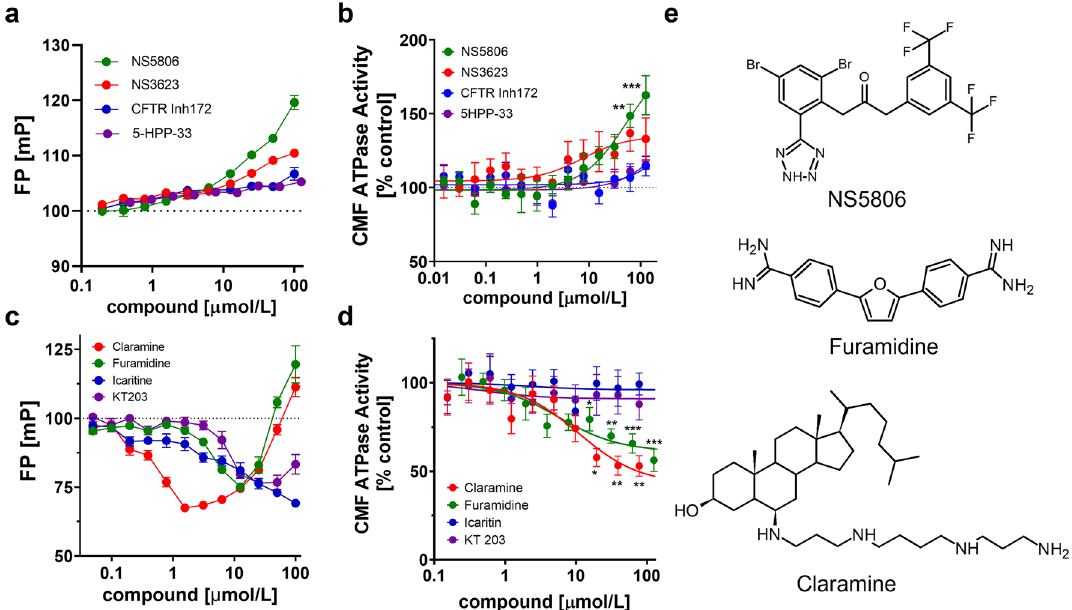
Figure 2. Validation of hit compounds from high throughput screens. ( a ) Dose-dependent effect of selected hit compounds on cTnC-cTnI SP interactions monitored by fluorescence polarization. ( b ) Dose-dependent effect of hit compounds from the cTnC-cTnI SP HTS on the ATPase activity of isolated bovine myofibrils at submaximal calcium activation (~ 30% of maximum activation). ( c ) Dose–response curves for selected hit compounds from the cTnC-cTnI AR HTS. ( d ) Dose-dependent effect of hit compounds from the cTnC-cTnI AR HTS on the ATPase activity of isolated bovine myofibrils at submaximal calcium activation (~ 70% of maximal activation). ( e ) Chemical structures of NS5806, Furamidine and Claramine. Means ± SEM, n = 3–7. Statistical significance of values vs control were assessed with a one-way ANOVA followed by Tukey’s multiple comparison test: * p < 0.05, ** p < 0.01, *** p <